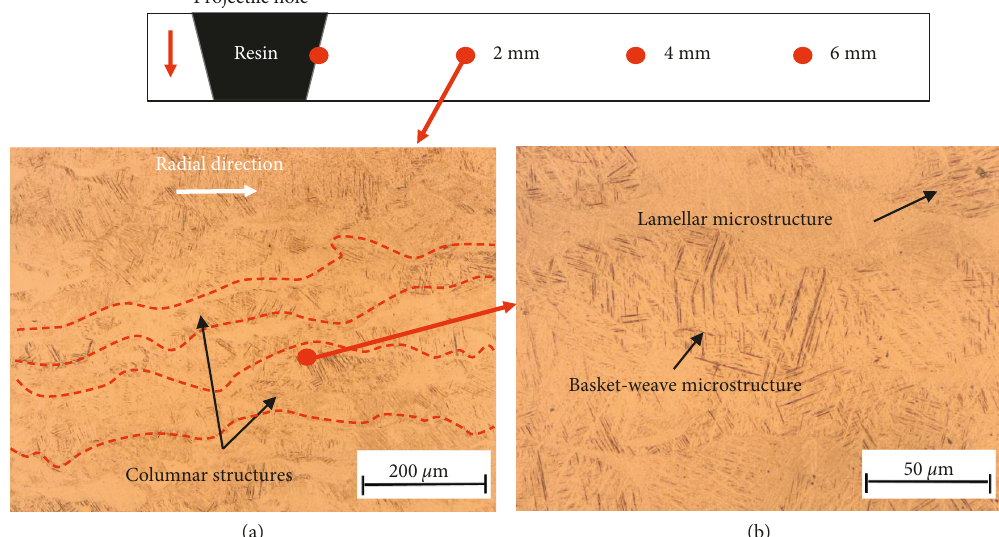
Figure 17: (a) Optical micrograph and (b) higher magnification optical micrograph, both at 2mm from the edge of the projectile hole through a 10mm thick